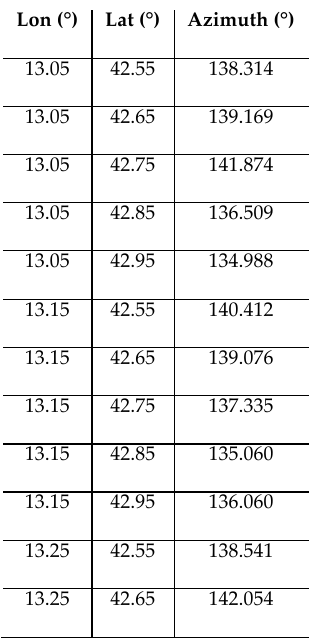
Table 3 : Coordinates and azimuths of SHmax inferred from the forecast moment tensor parameters, for each cell shown in Figure